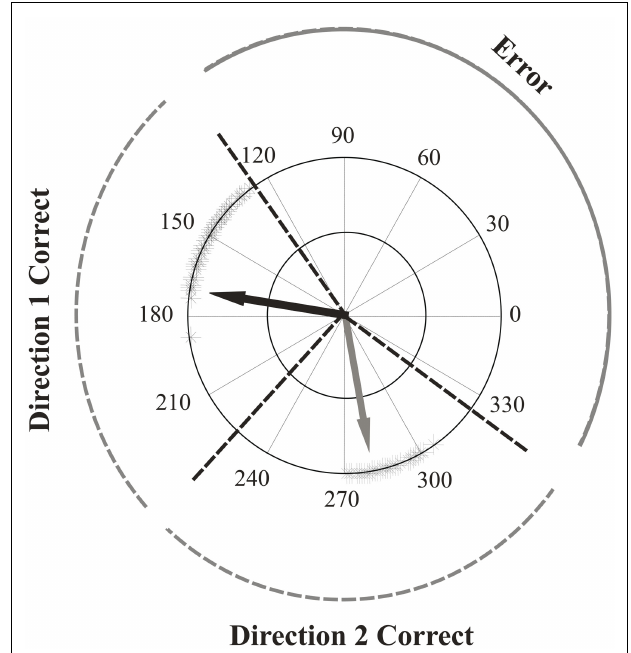
error ranges indicated. Shown are all the both-correct responses one participant made to surfaces that were moving at between 170–190˚ and 260–280˚. Note that the responses are repulsed away from each other and from the real directions. Overlaid are the ranges used to determine the both-correct, one-wrong and both-wrong rates for surfaces moving at 170˚ and 280˚. Correct ranges were defined as halfway between the two directions to ± 45˚. One-wrong rates then were trials in which participants clicked on the response circle within the correct range for either direction one or direction two, and made a second response within the error range. Both-wrong rates were based on trials in which participants made both clicks on the response circle within the error